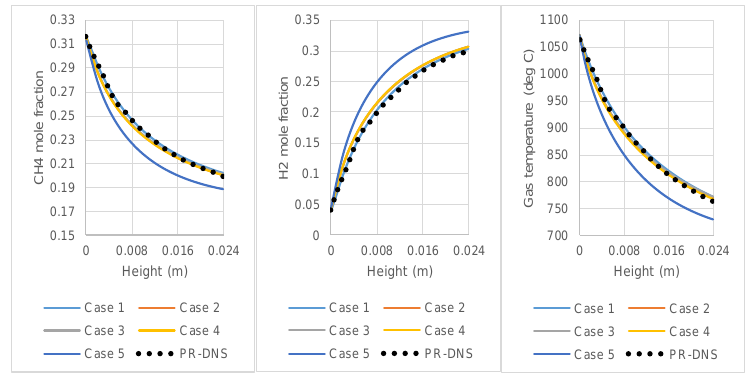
Figure 13. Comparisons of different 1D model setups against PR-DNS results.